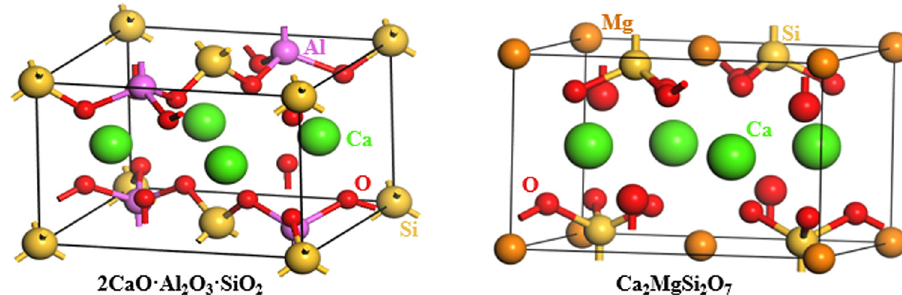
Figure 3: Phase structure of CaCO 3 and MgCO 3 .